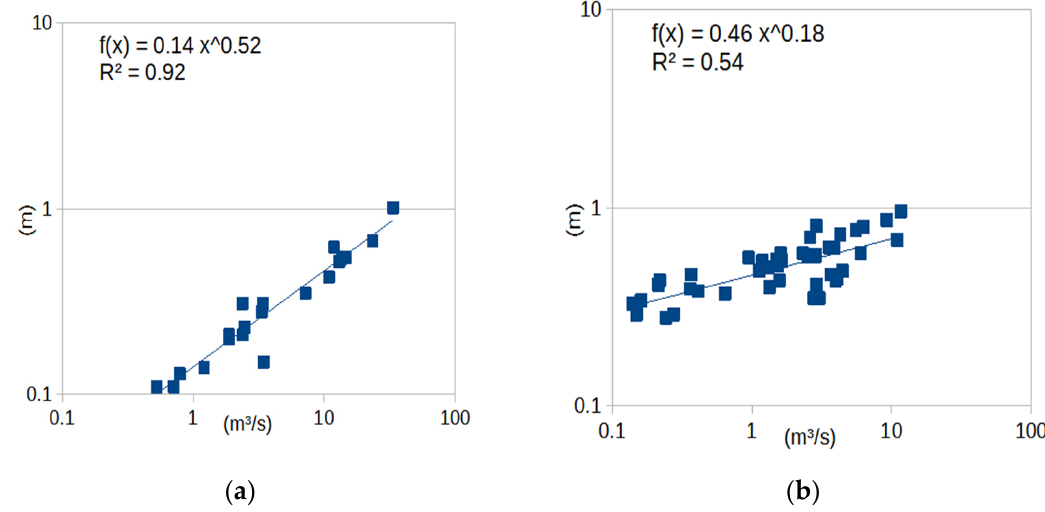
Figure A3. The fit of a power law trend line to data partitioned with DBSCAN: ( a ) period 1 (02/1964– 04/1966); ( b ) period 2 (05/1966–01/1972).